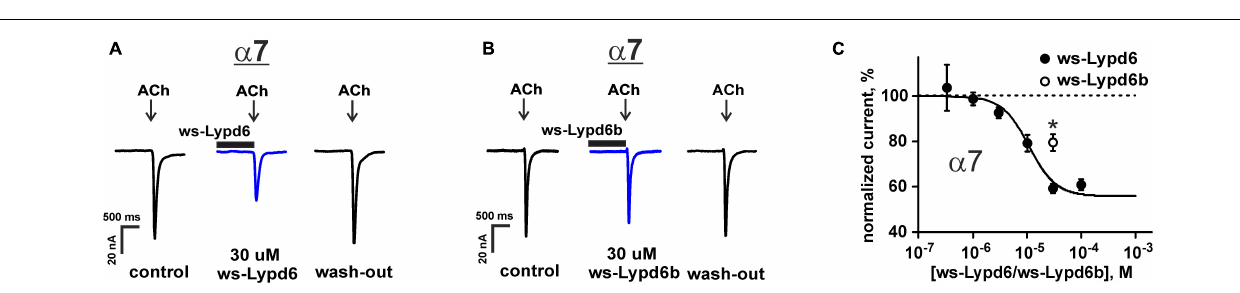
Frontiers in Cell and Developmental Biology |